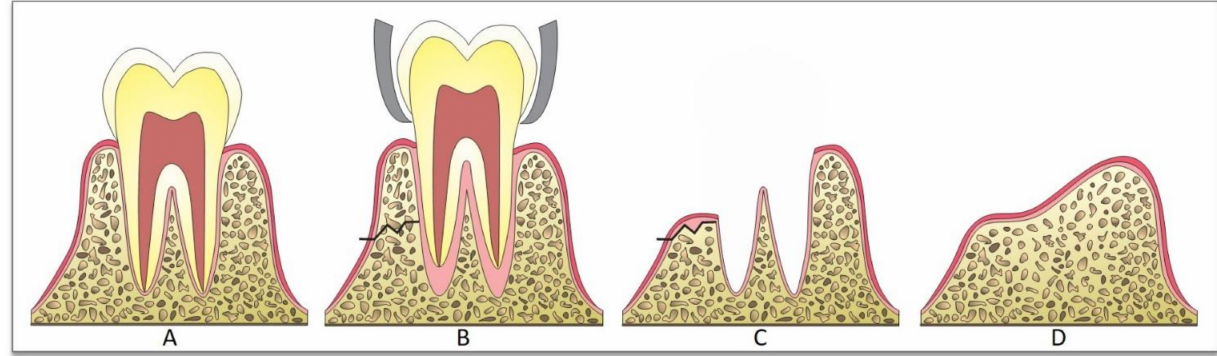
Figure 3. Diagram showing the change in the volume of the alveolar bone ridge resulting from the traumatic tooth extraction. ( A ) Proper dental implantation. ( B ) Dental extraction with fracture of the alveolar bone wall. ( C ) Bone condition after tooth extraction. ( D ) Alveolar bone